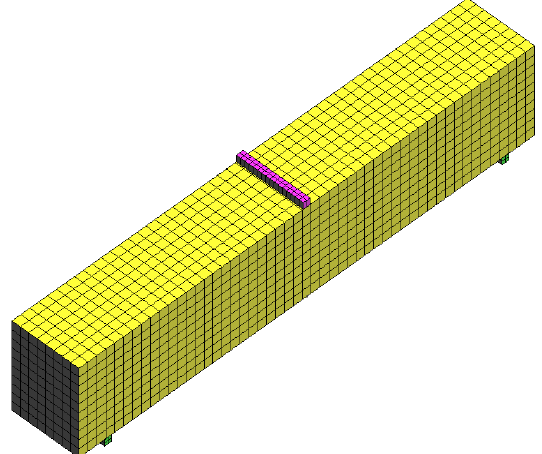
Figure 3. Numerical model of the reinforced concrete beam (M8).